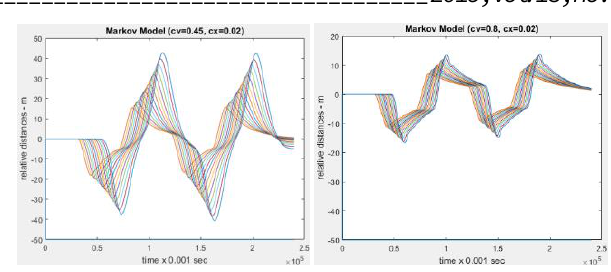
Fig. 17. The impact of Markov model parameters on the relative distances.